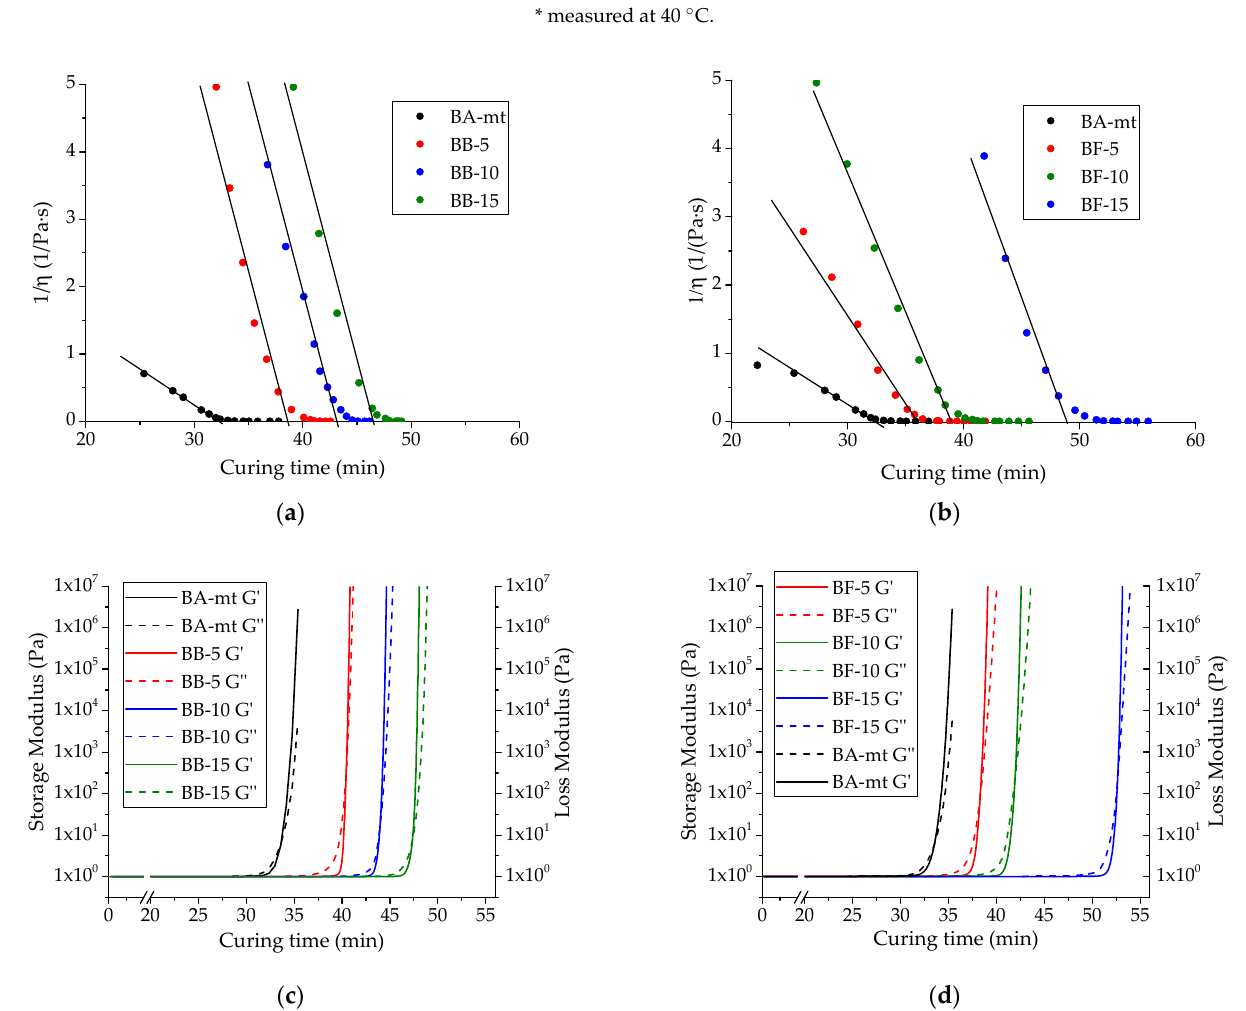
Figure 6. Dependencies of reciprocal viscosity 1/ η on curing time at 180 ° C for compositions with BD ( a ) and FUR ( b ) and dependencies of Storage Moduli and Loss Moduli for compositions with BD ( c ) and FUR ( d ). Table 3. Gelation and crossover points at 180 ° C, viscosity at 40 ° C and tackiness at 25 ° C for compositions under study. Formulation Index